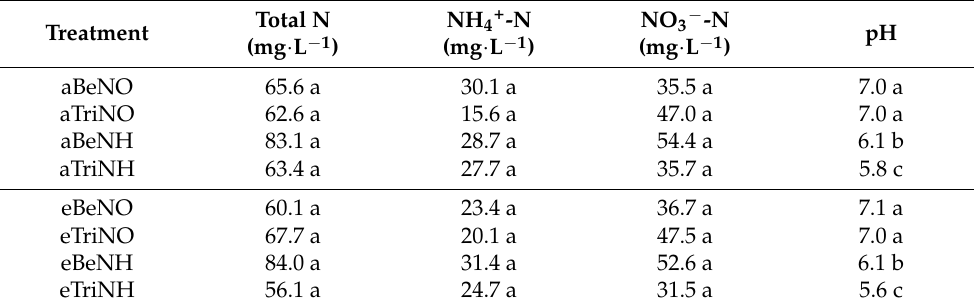
Table 1. Chemical parameters of the growth substrate at harvest (44–45 DAS). n = 3.